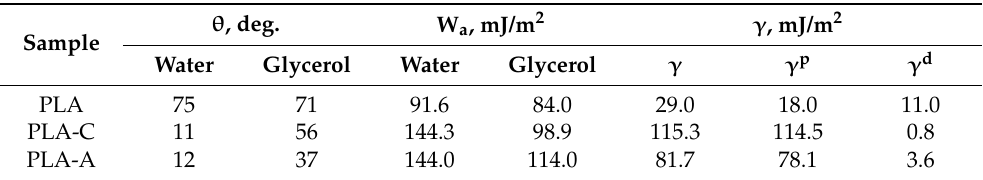
Table 3. Surface contact properties of initial and plasma ‐ treated PLA films.